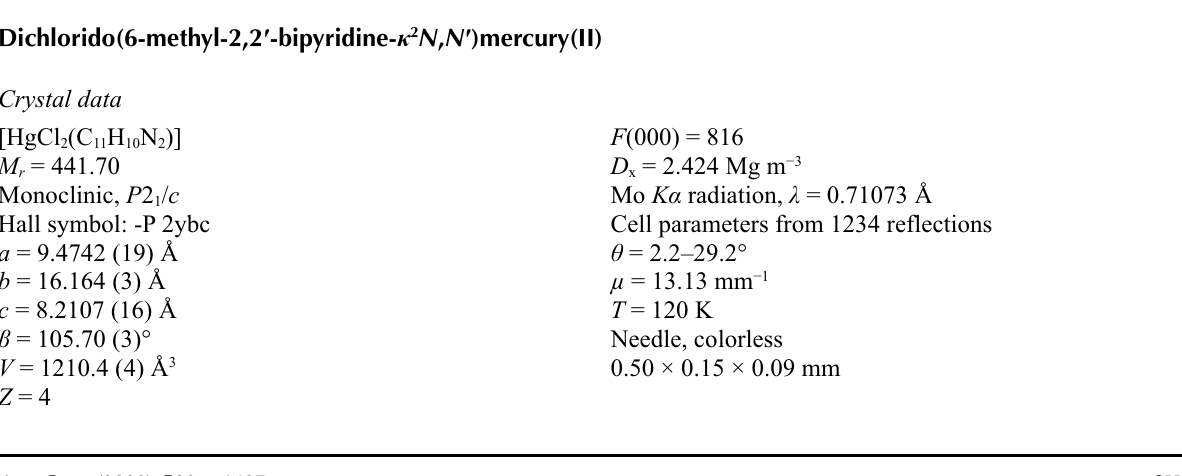
A partial packing diagram of the title